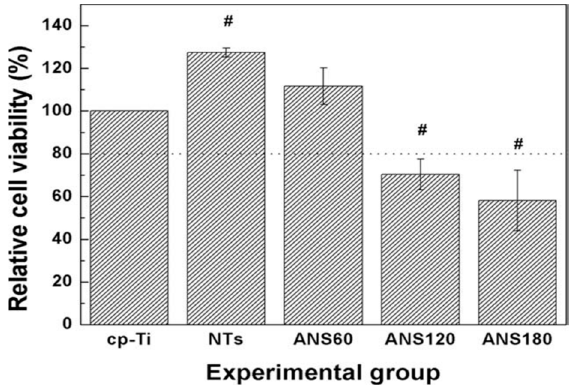
Figure 35. The viability of MC3T3-E1 murine osteoblasts obtained from the MTT assay. Error bars indicate the standard deviation ( n = 5); # p < 0.05 compared with commercial pure Ti (cp-Ti). Reproduced with permission from [261]. Copyright Wiley, 2014.